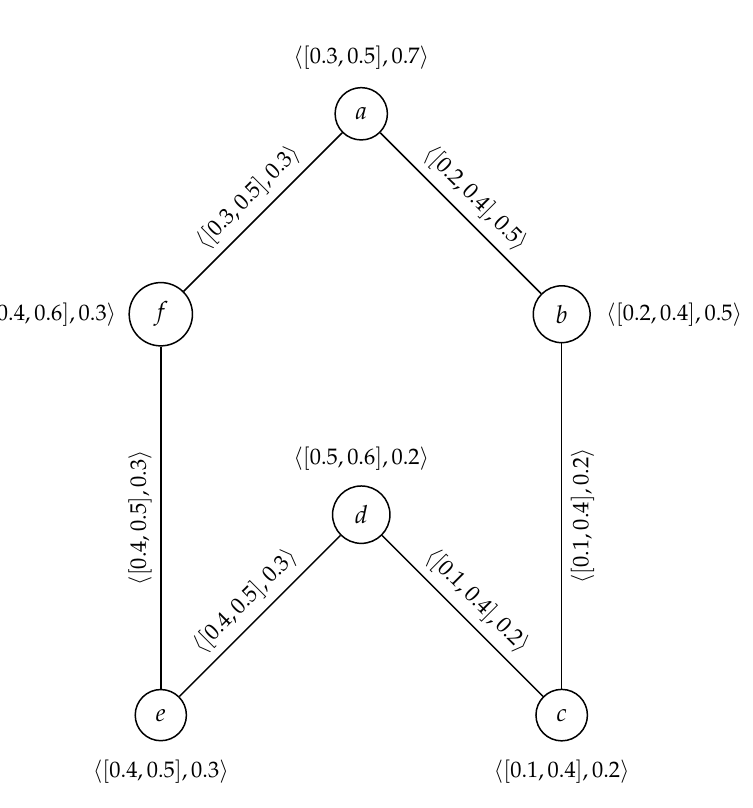
Figure 2. Cubic cycle G